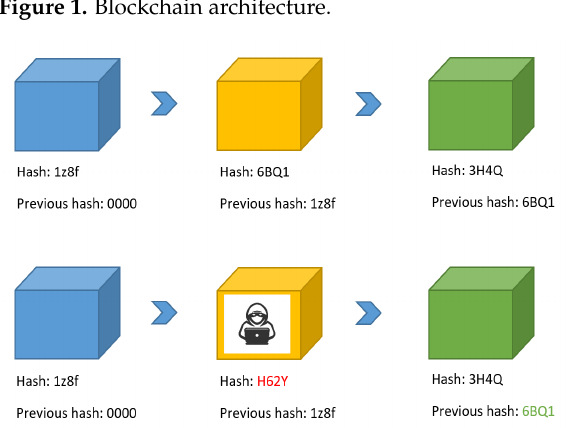
Figure 2. Blockchain before and after hacking.